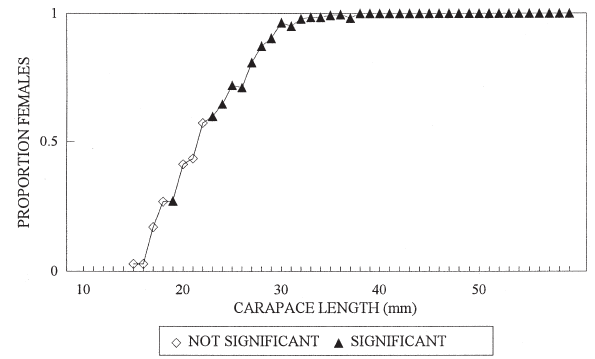
F IG . 4. – Representation of the sexual ratios (proportion of females) by size from shrimps from Santa Pola, showing the significance of the dominance by sex in each size